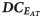
Comparison of the estimated value of DCEAT.